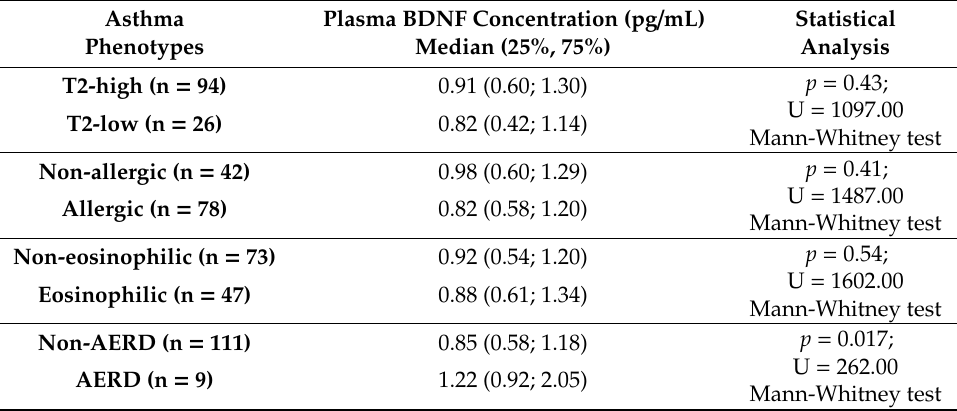
Table 9. Plasma BDNF concentration in patients with di ff erent asthma